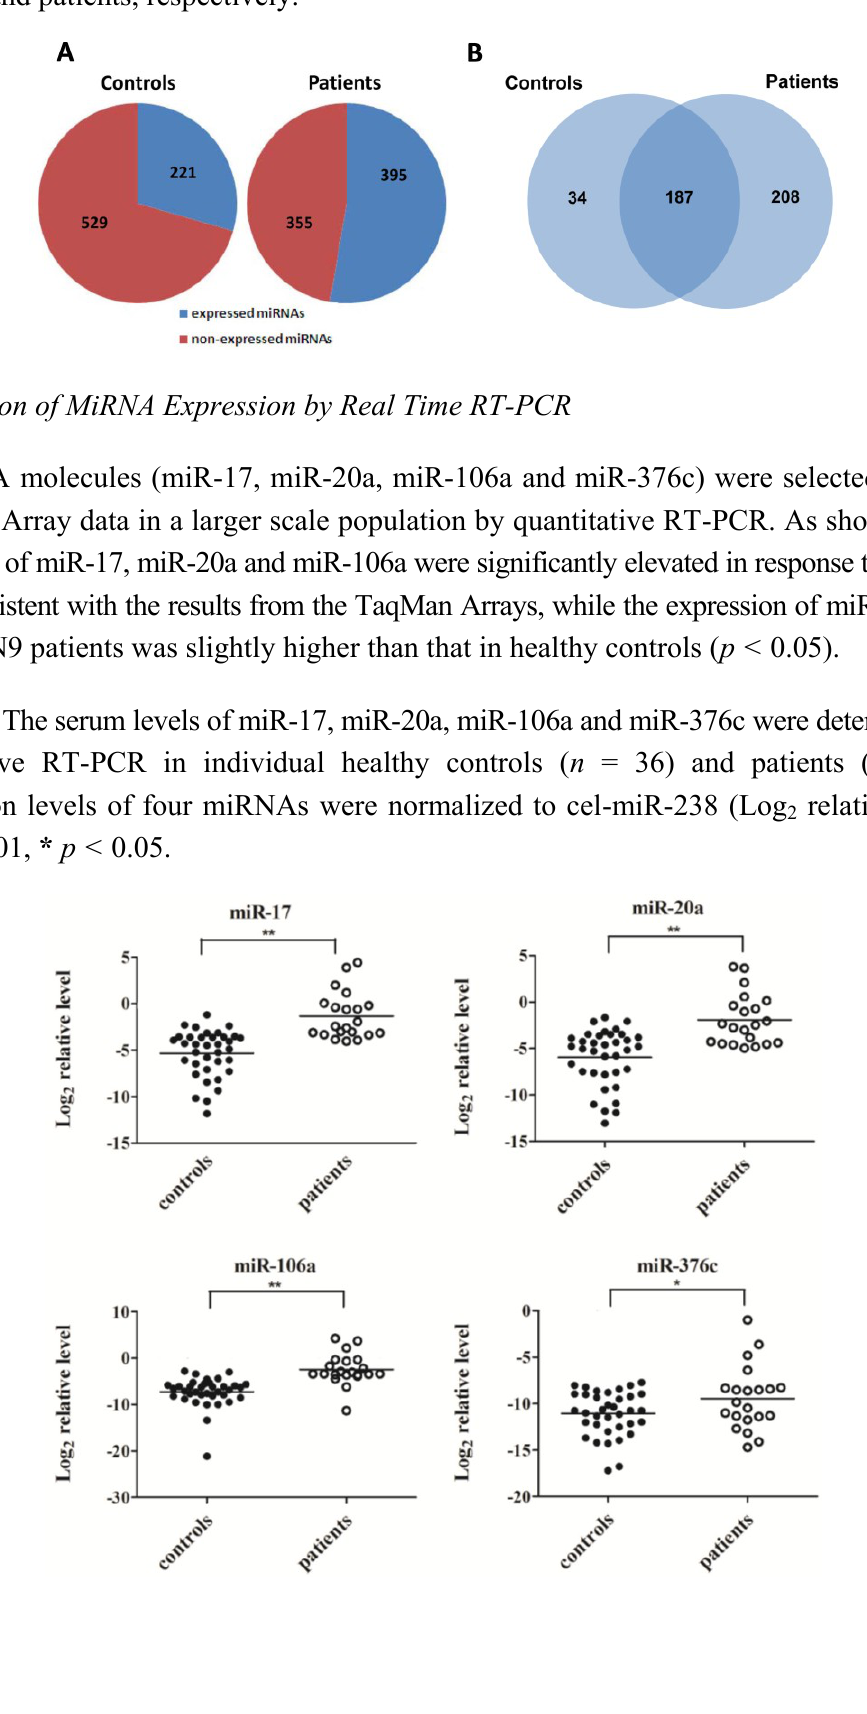
Figure 1. Global analysis of serum miRNA expression profiles between healthy controls and H7N9 virus-infected patients. ( A ) The distribution of expressed and non-expressed miRNAs in serum pools of controls and patients; ( B ) 187 miRNAs were commonly expressed in both groups, whereas 34 and 208 miRNAs were expressed in serum pools of controls and patients, respectively.